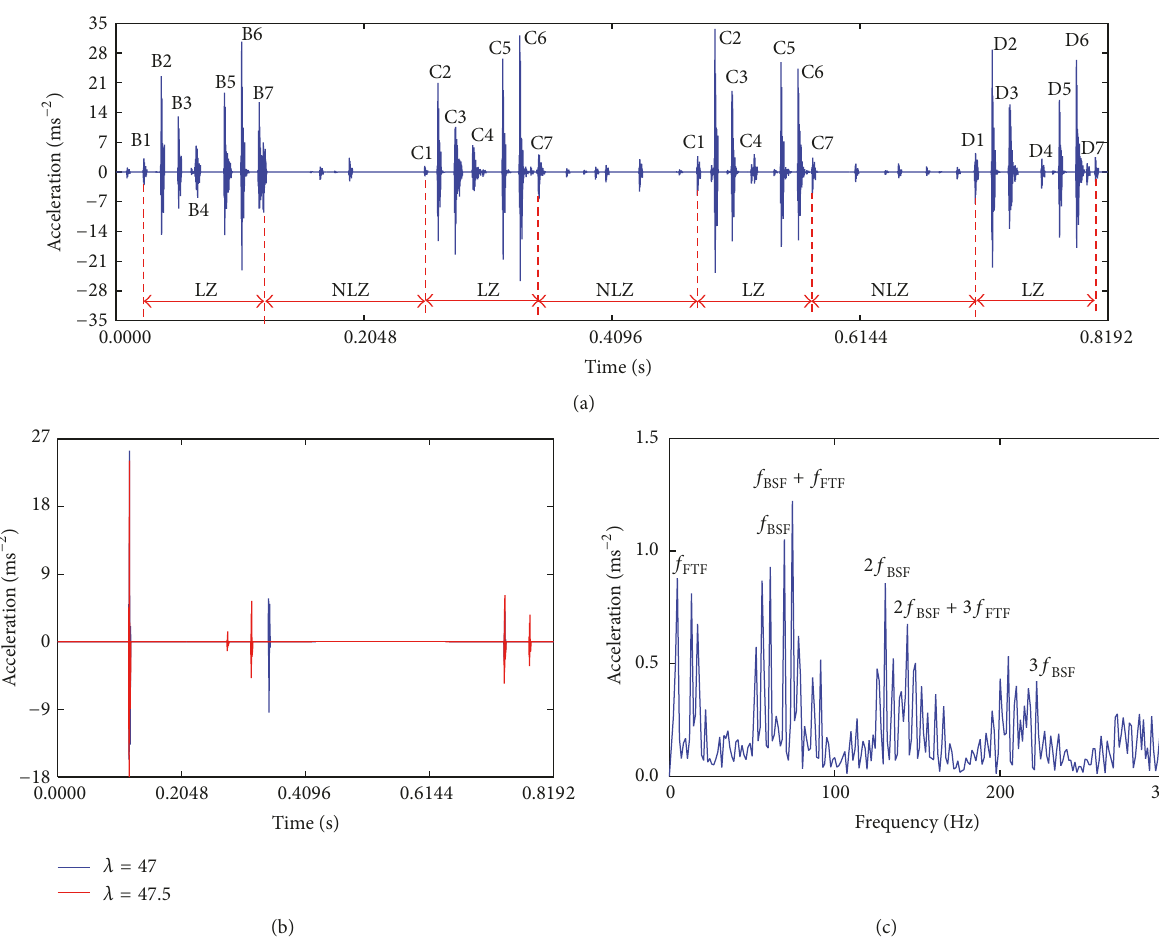
Figure 16: The extracted impulse: (a) by proposed appropriately sparse impulse extraction; (b) three other indicators; (c) the envelope spectra of (a).